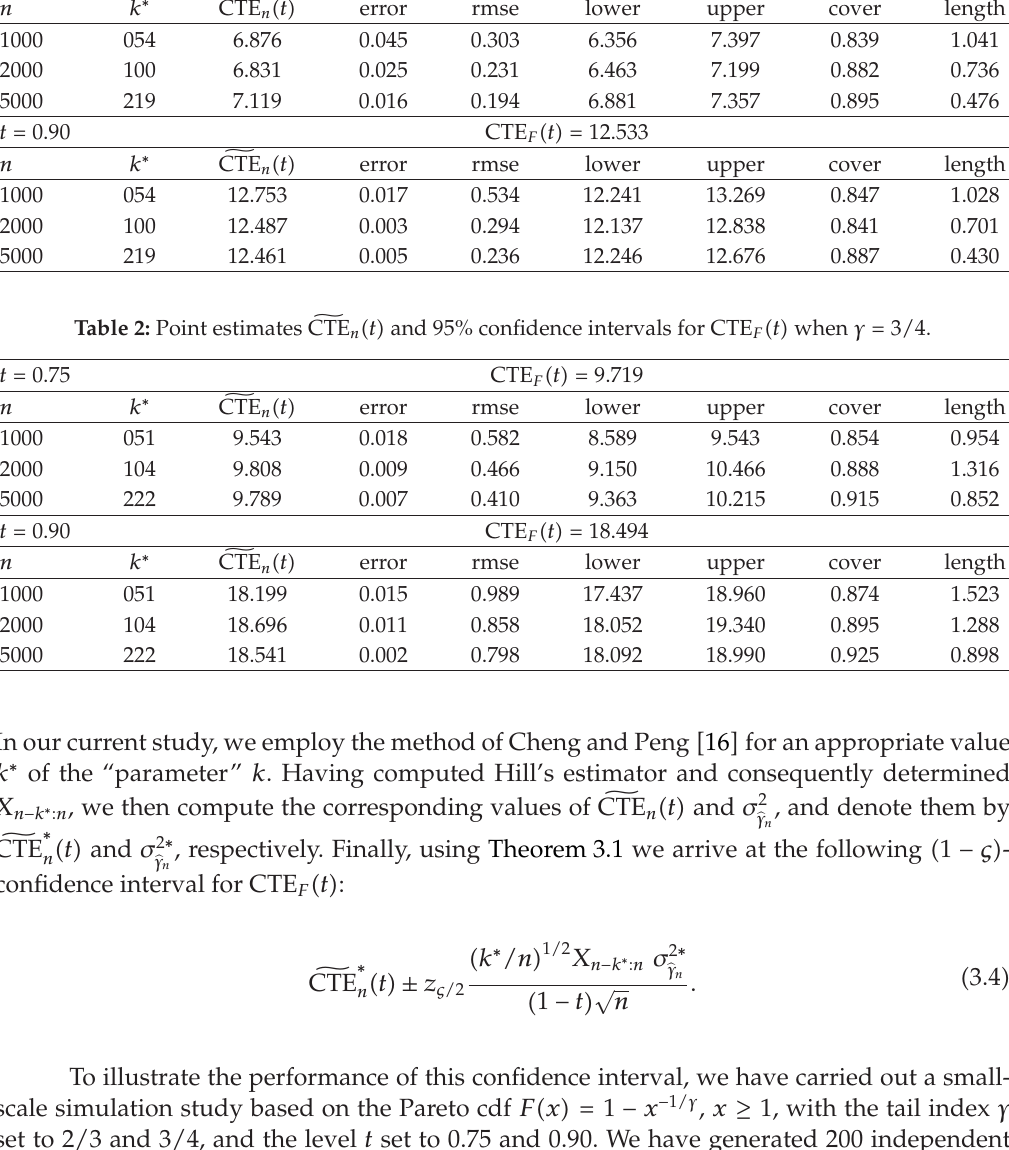
(cid:8) Table 1: Point estimates CTE n (cid:2) t (cid:3) and 95% confidence intervals for CTE F (cid:2) t (cid:3) when γ (cid:7) 2 / 3. t (cid:7) 0 . 75